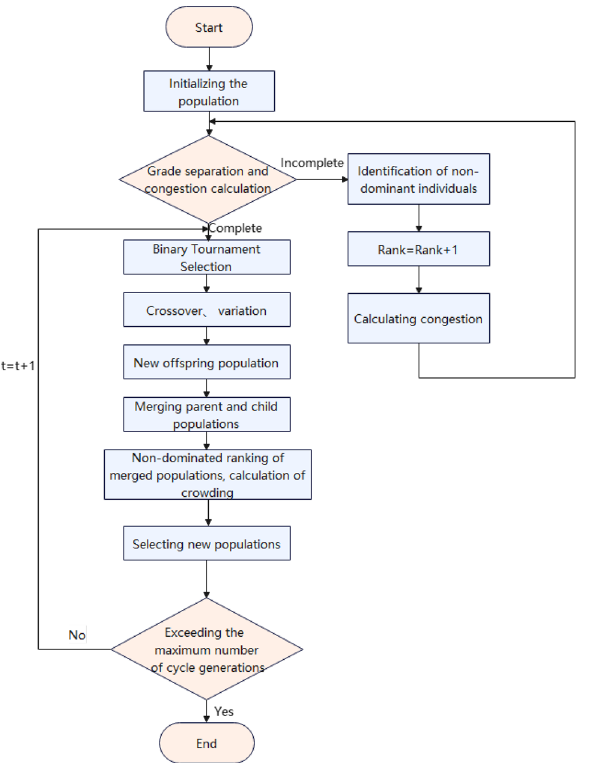
Figure 3. Basic flow chart of NSGA-II algorithm.